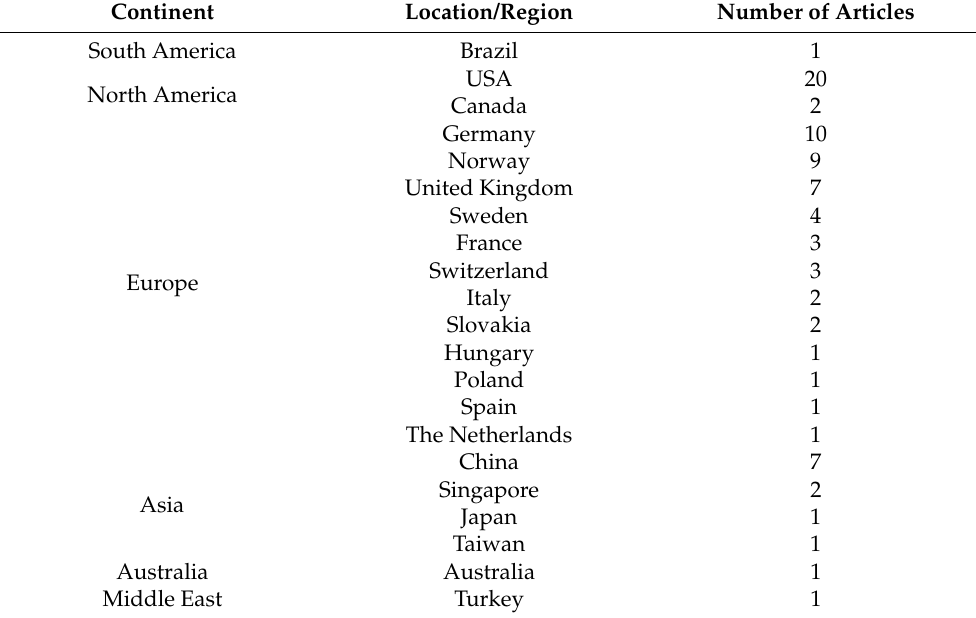
Table 3. Locations where eye tracking research was conducted on the aviation, maritime, and construction